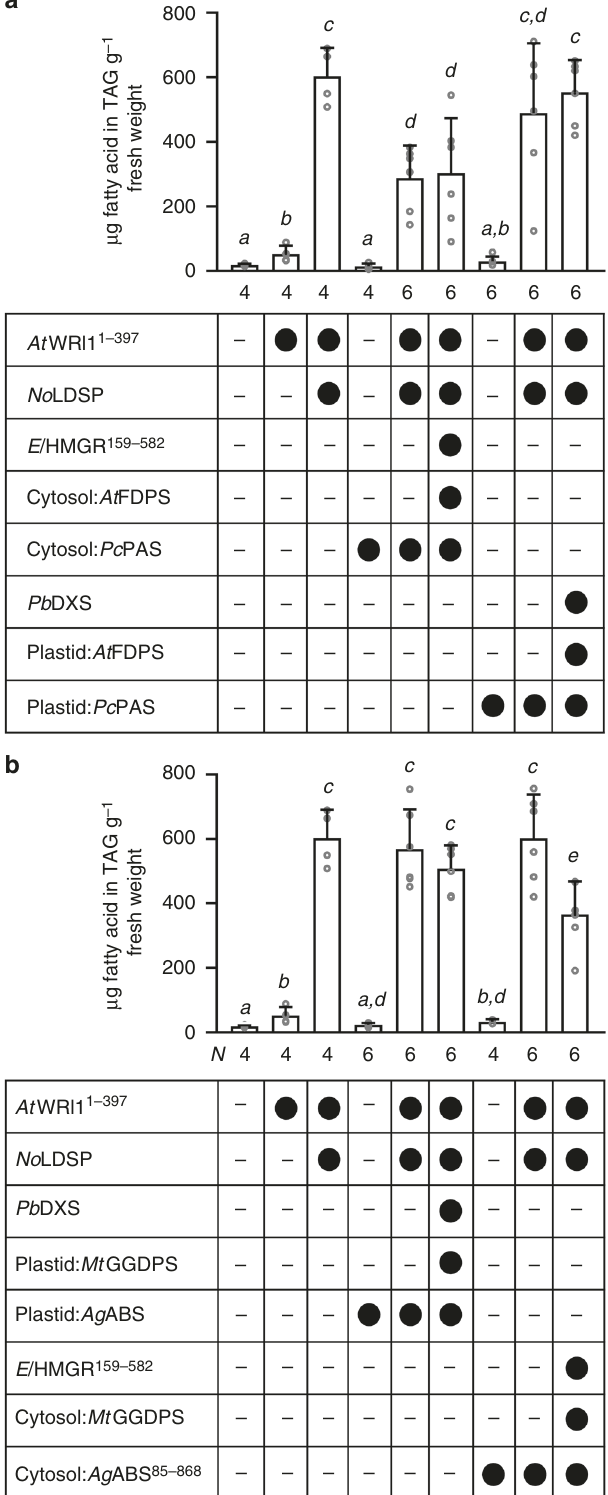
Fig. 3 Triacylglycerol yield in engineered N. benthamiana leaves. TAG accumulation was initiated through ectopic expression of WRINKLED1 ( AtWRI1 1 – 397 ) and further enhanced through co-expression of No LDSP. The impact of engineered patchoulol ( a ) and diterpenoid production ( b ) on TAG yield is depicted. The different construct combinations are indicated below each bar (black circle, was included; minus, was not included). Data were analyzed by Shapiro – Wilk, Welch – ANOVA ( a P < 0.0001; b P < 0.0001) and Brown – Forsythe ANOVA ( a P < 0.0001; b P < 0.0001) followed by t -tests (unpaired, two-tailed, Welch correction). Data are presented as individual biological replicates and bars representing average levels with SD ( N indicated below each bar). This experiment was replicated twice. Statistically signi fi cant differences are indicated by a-e based on t -tests ( P < 0.05). Source Data are provided as a Source Data fi